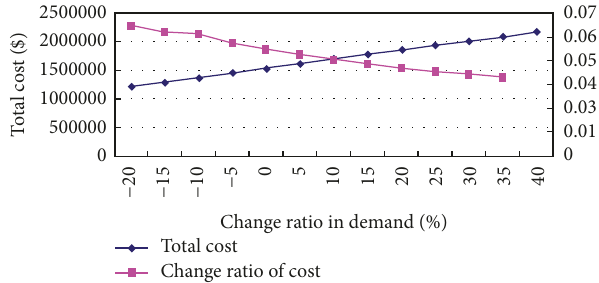
Figure 3: Total cost and its change ratio of different demands.